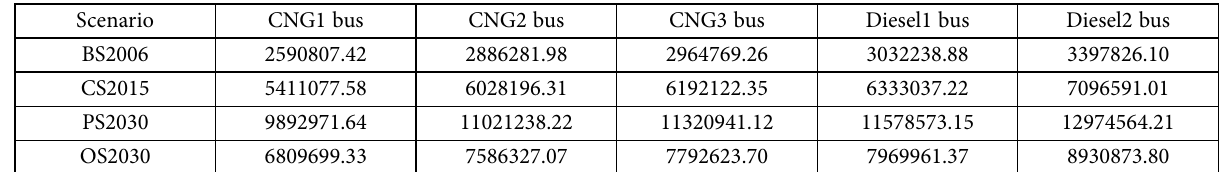
Table 5. Annual external costs of CO 2 emissions for the whole road network for different bus concepts according to various scenarios [€/year]